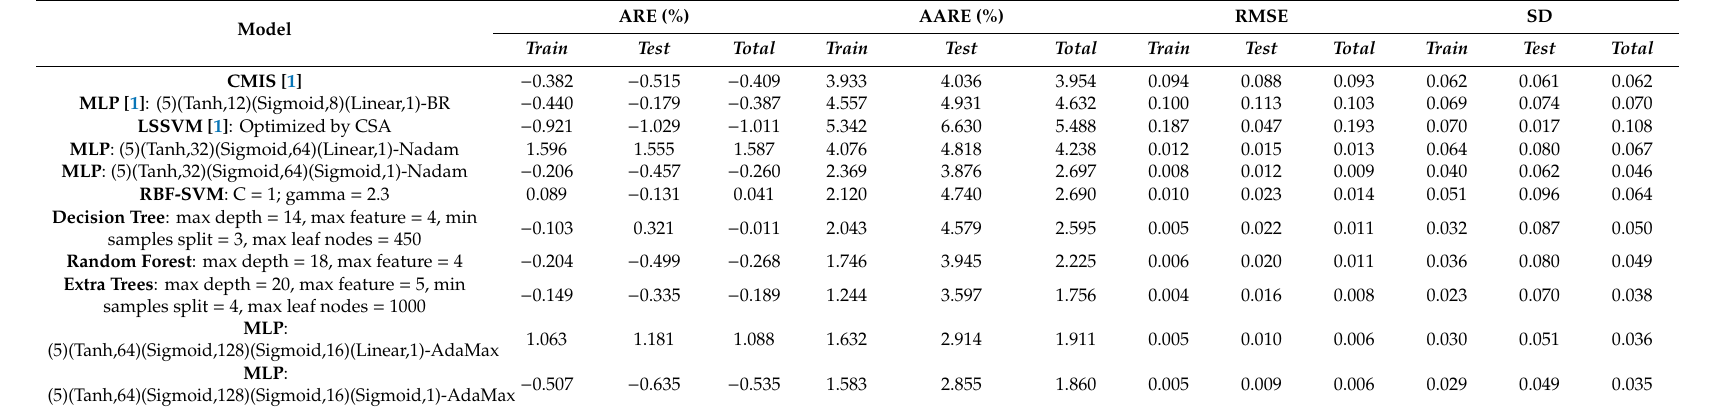
Table 2. Statistical error analysis for prediction of the relative viscosity of